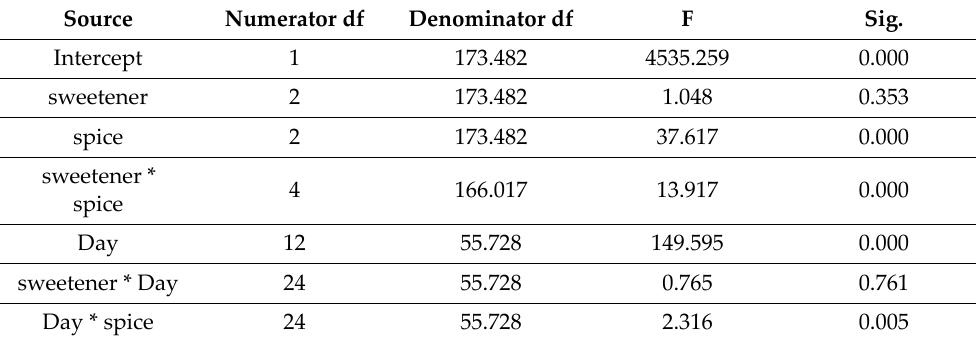
Table A2. Type III Tests of Fixed Effects for Total Anthocyanins (from SPSS).